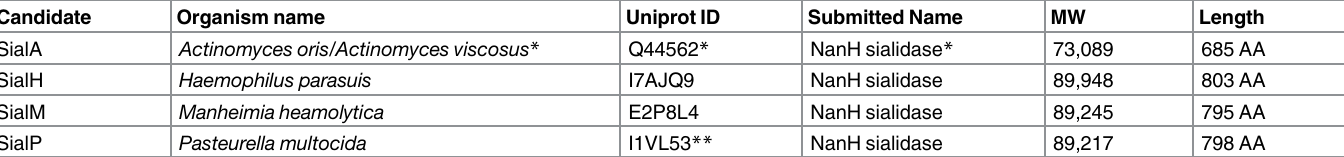
Table 2. An overview of the origin and selected properties of the candidate genes.